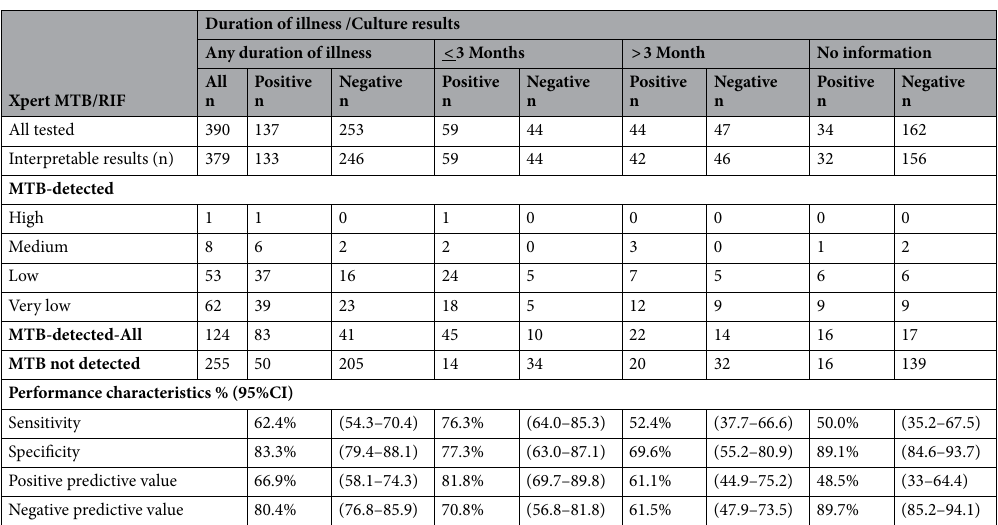
Table 2. Performance of Xpert MTB/Rif assay against culture in people with short (≤ 3 months) versus long clinical history (> 3 months). The difference in the performance of Xpert between subgroups of patients having short clinical history compared to those with a longer history of illness, sensitivity ( P = 0.012), specificity ( P = 0.409), PPV ( P = 0.028), and NPV ( P =